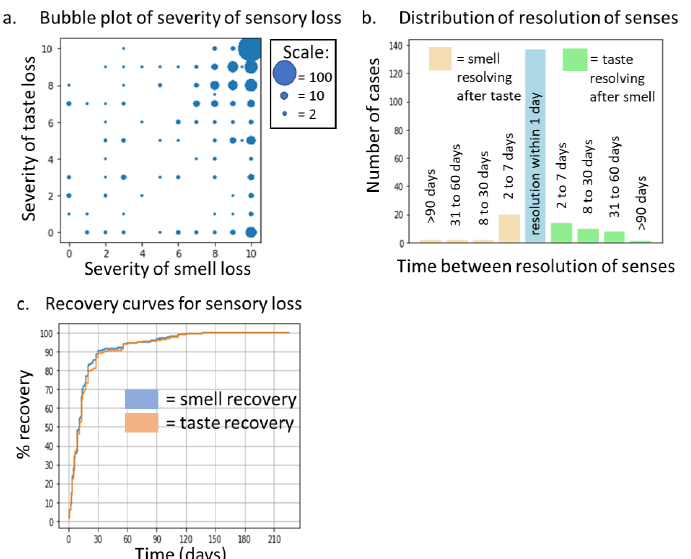
Figure 2. ( a ) Bubble plot showing the relationship between taste and smell loss severity, n = 421. ( b ) Plot indicating the differential time for resolution of taste and smell loss, n = 207. ( c ) Recovery curve for both taste and smell loss, n = 207.